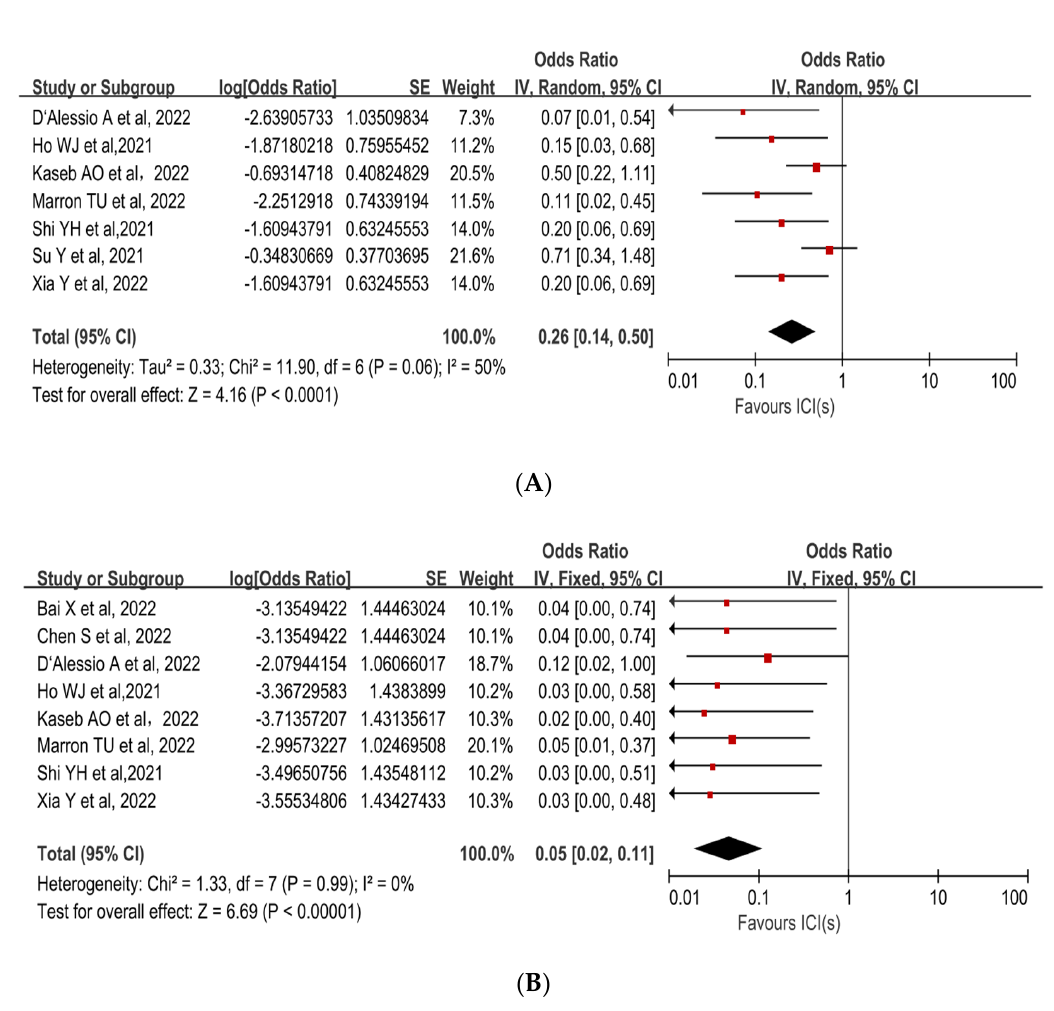
Figure 3. Forest plot of the safety of neoadjuvant immune checkpoint inhibitors in resectable hepatocellular carcinoma. ( A ) Grade 3−4 TRAEs, ( B ) Surgical delay rate. ICIs: immune checkpoint inhibitors. TRAEs: treatment-related adverse events [30–38].